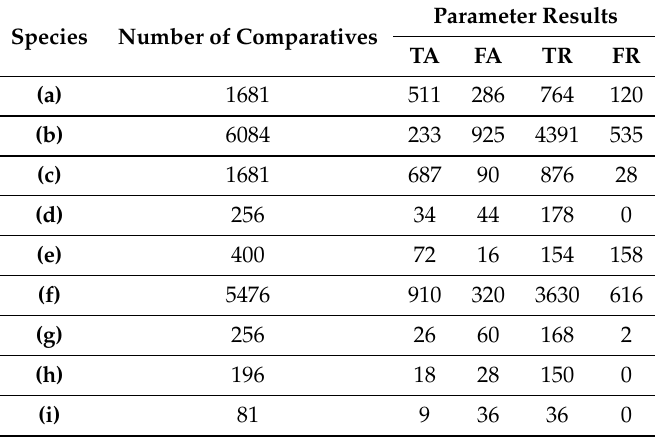
Table 4. Identification evaluation of the automatic